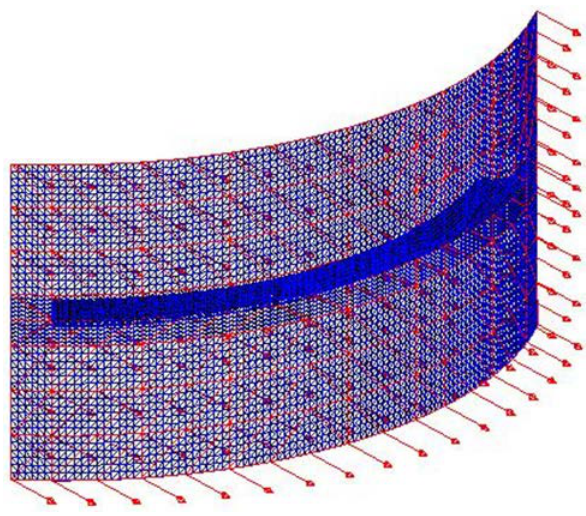
Figure 7: 153 Sensors in the FEM model